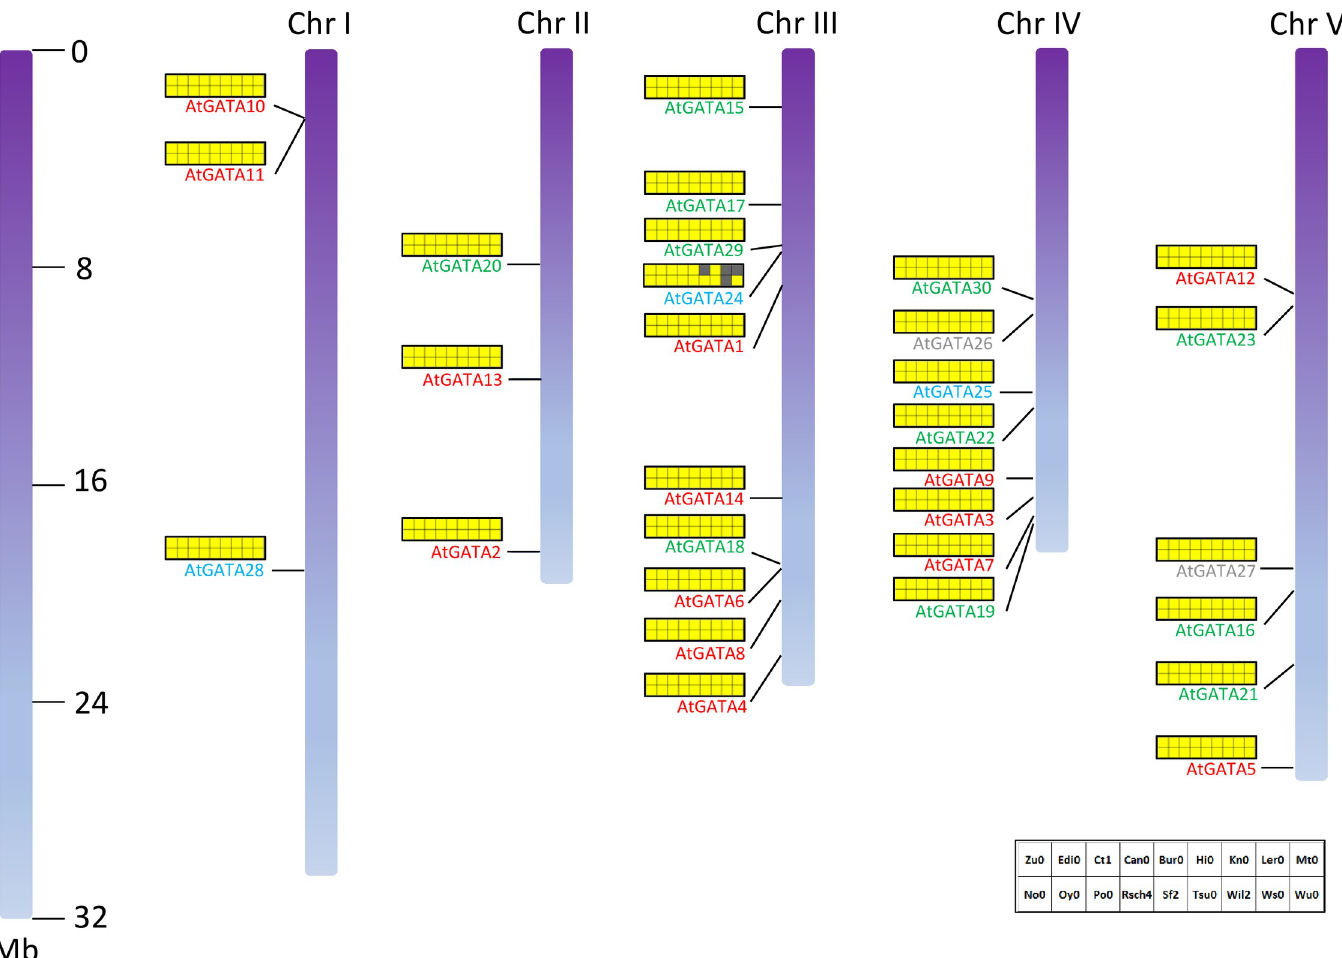
Fig 6. Chromosomal distribution of A . thaliana GATA genes among 19 genomes. Gradient purple bars indicate the chromosome of A . thaliana Col0. The left bar indicates the length of the chromosome. Red, green, sky blue, and gray GATA gene names mean subfamilies I, II, III, and IV, respectively. An array of small squares beside chromosomes presents the existence of GATA genes among 18 A . thaliana genomes: yellow color means existence and white color is non-existence case.